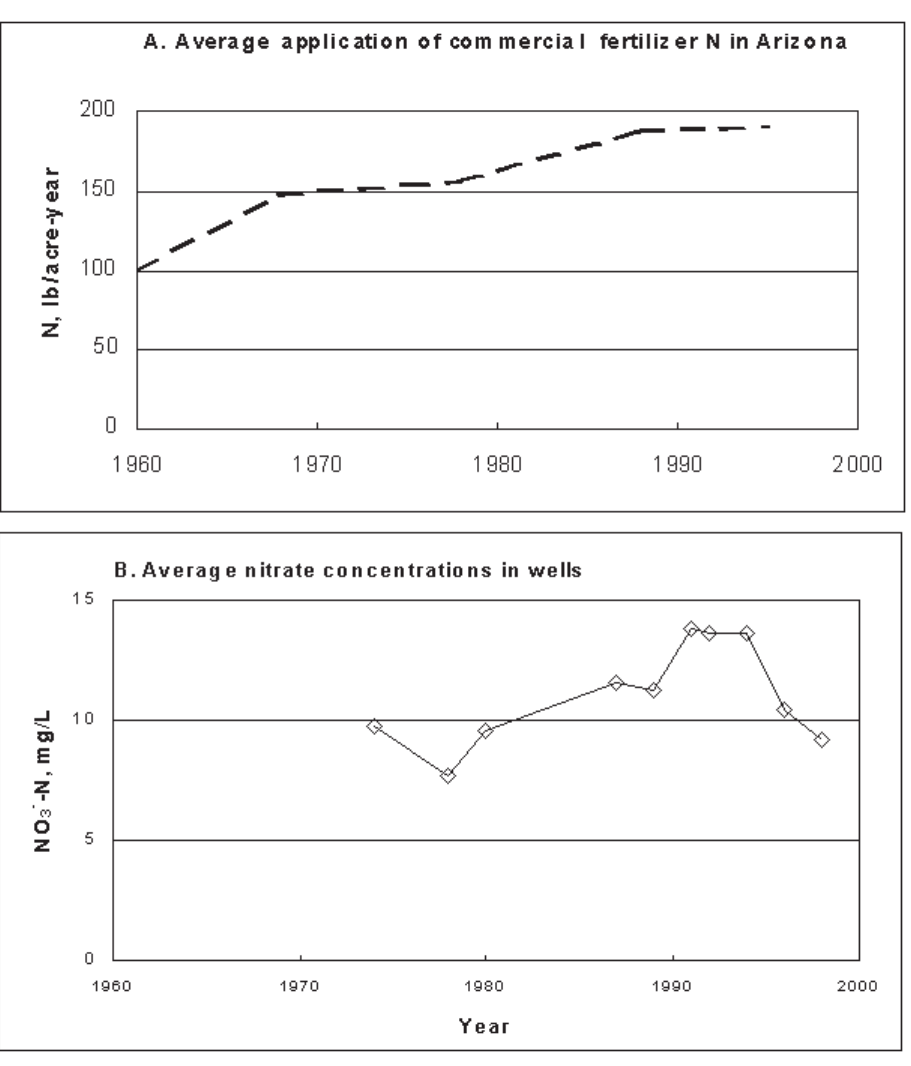
FIGURE 2. (A) Application of commercial N fertilizer in Arizona[6], and (B) average (krigged) groundwater nitrate concentrations in the CAP